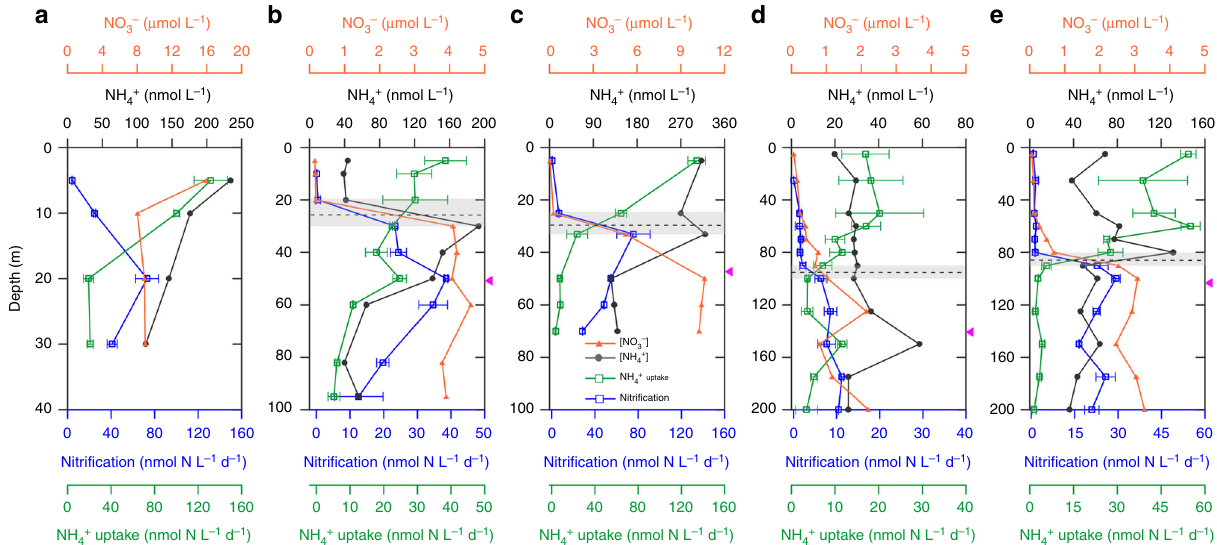
Fig. 2 Depth pro fi les of nutrient concentrations and NH 4 + consumption rates in the Subtropical Northwest Paci fi c in spring of 2015. a coastal station P1; b , c Shelf stations P5 and C5; d , e basin stations K1 and X1. The fi gure shows NO 3 − concentrations (orange solid dots); NH 4 + concentrations (gray solid dots); NH 4 + uptake rates (green open squares) and nitri fi cation rates (blue open squares). Gray bars mark the depth range with the steepest NO 3 − gradient and the black dashed lines within them show the nitracline depth; pink triangles on the right Y -axis mark the euphotic zone depth (0.1% of surface PAR). Error bars of NH 4 + uptake and oxidation rates are represented by the standard deviation of triplicates, and are smaller than the symbols where not visible